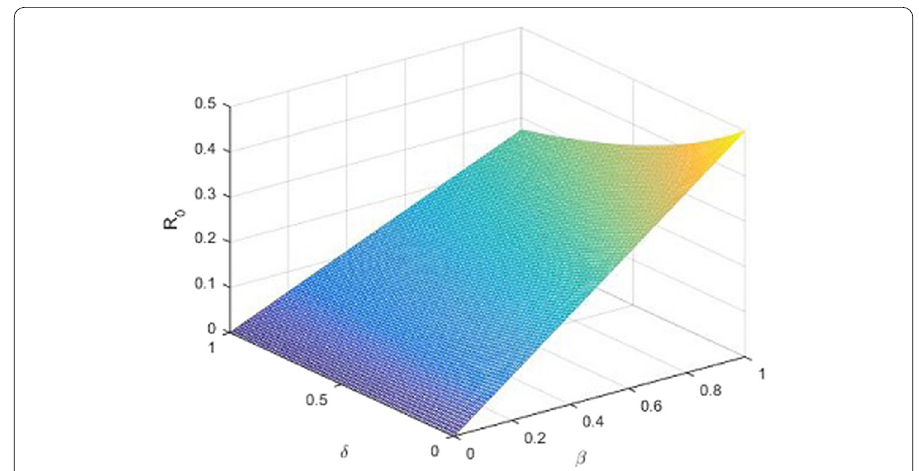
Figure 2 Numerical simulation of the reproductive number as functions of β and δ